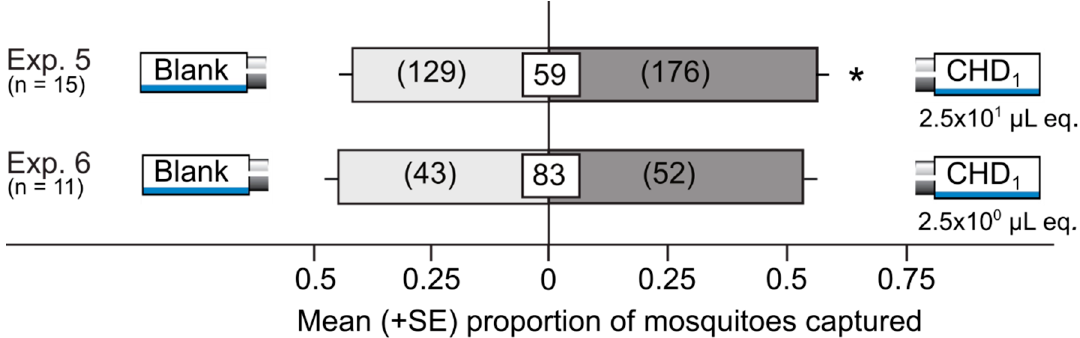
Figure 3. Mean proportion (+SE) of female yellow fever mosquitoes , Aedes aegypti , captured in Experiments 5 and 6 in paired traps that were baited with the CHD 1 ( a synthetic blend of crude pea aphid honeydew odorants prepared according to our own data; Figure 2 and Table 2) or fitted with a corresponding solvent (blank) control. Numbers in parentheses represent the total number of mosquitoes selecting a test stimulus, and numbers within white squares indicate the mean percentage of mosquitoes not captured (non-responders). An asterisk (*) indicates a significant preference for a test stimulus ( p < 0.05; binary logistic regression). The dose of 2.5 × 10 1 µ L equivalents (eq.) of honeydew approximates the amount of honeydew produced by 25 pea aphids per day